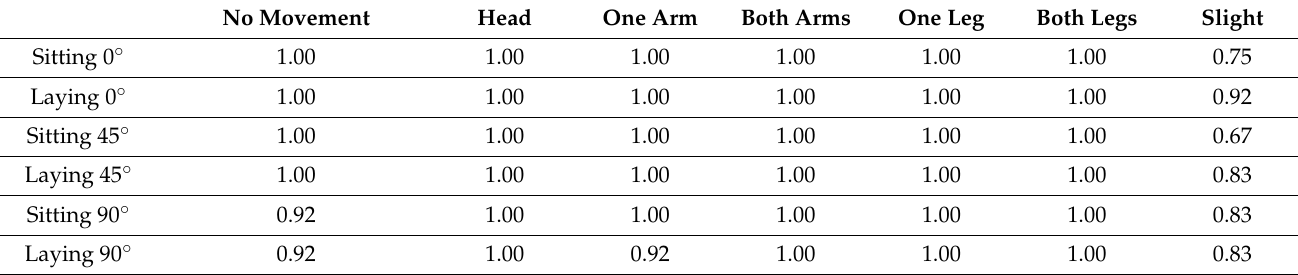
Table 4. Ratios of correctly predicted classes for each position, angle, and movement for the IRT data from the 12-subject group (approx. each 0.08 accounts for a correctly predicted video). No Movement Head One Arm Both Arms One Leg Both Legs Slight Sitting 0 ◦